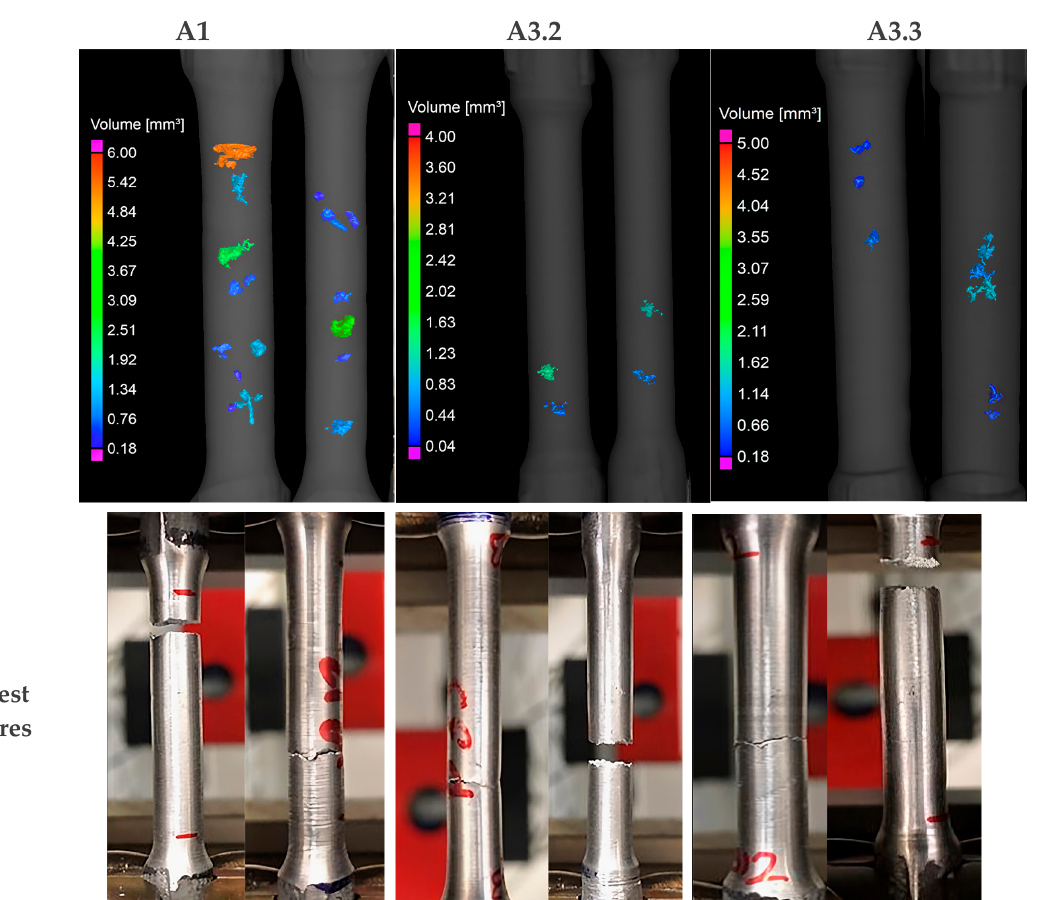
Figure 11. ( a ) CT reconstruction images of the tested specimens; ( b ) Tensile Post test crack pictures